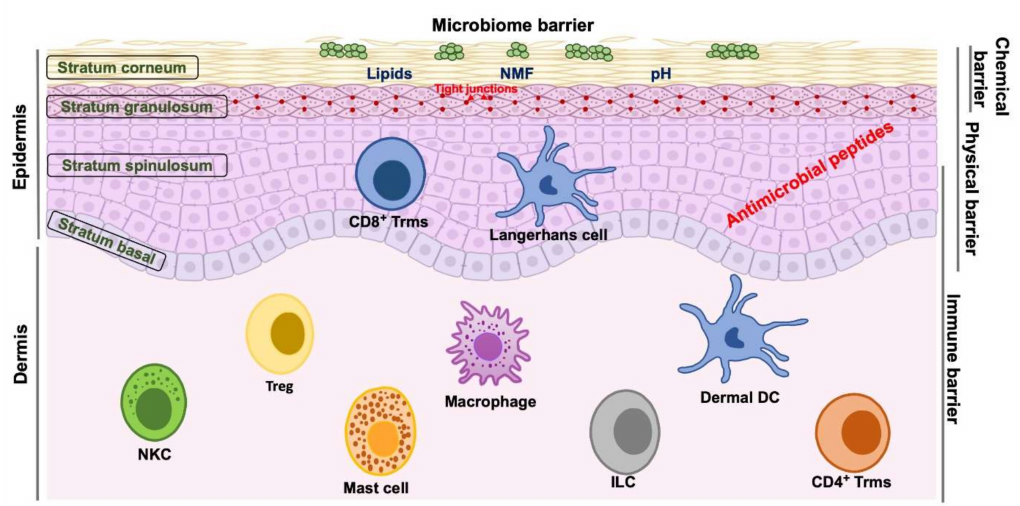
Figure 1. Components of the cutaneous barrier. DC: dendritic cell, ILC: innate lymphoid cell, NKC: natural killer cell, NMF: natural moisturizing factor; Treg: regulatory T-cell; Trm: resident-memory